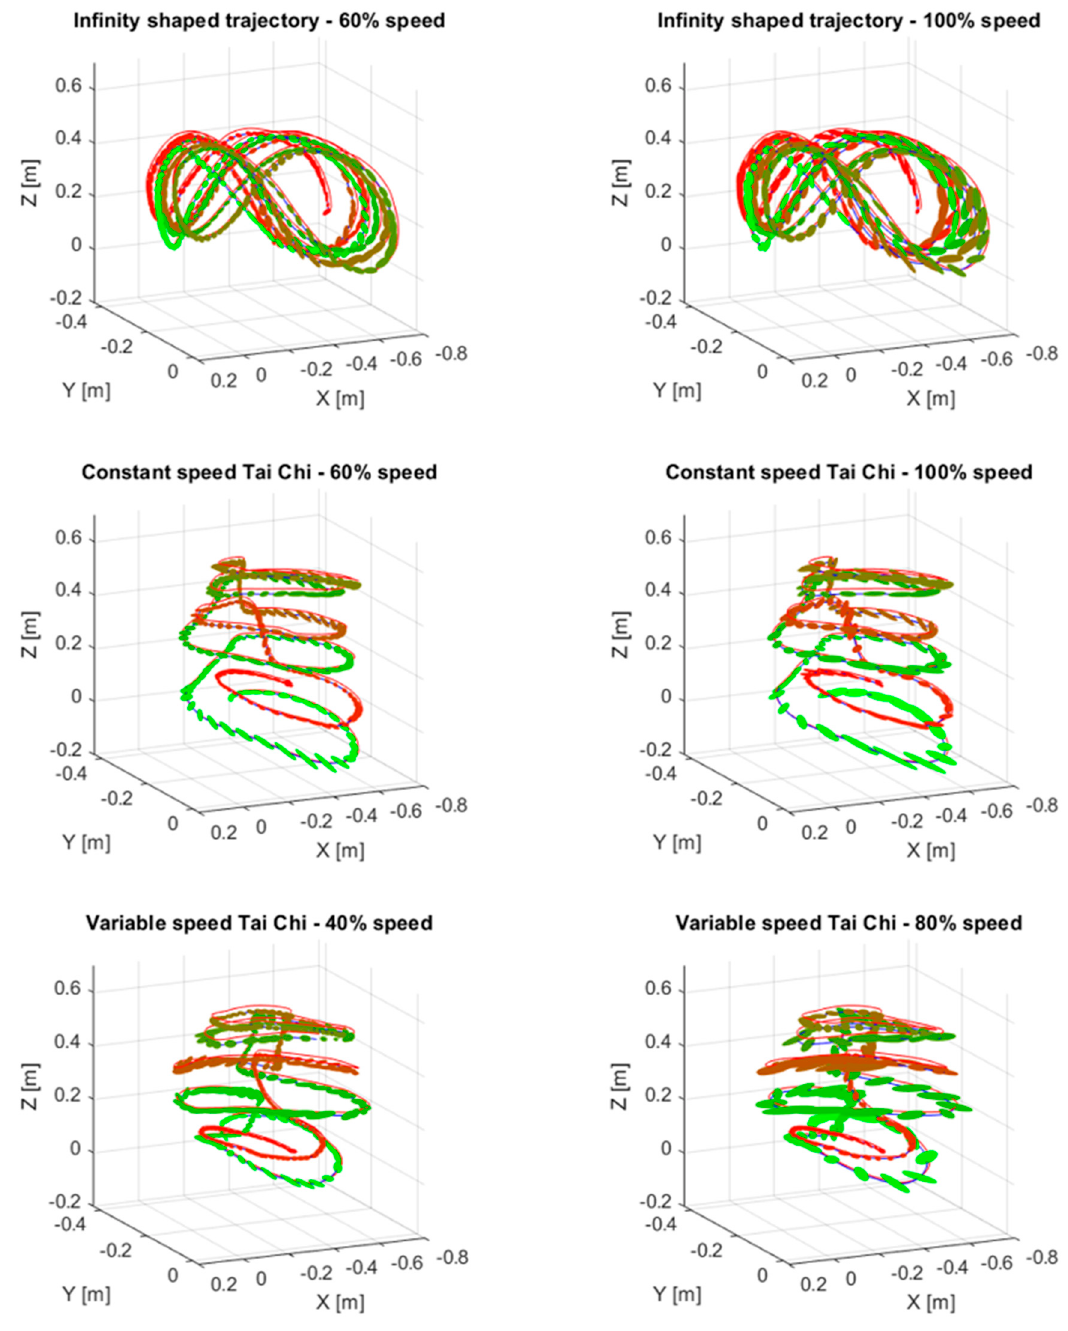
Figure A2. Trajectory with error ellipsoids. The color shifts from red to green over time during target’s move- ment.